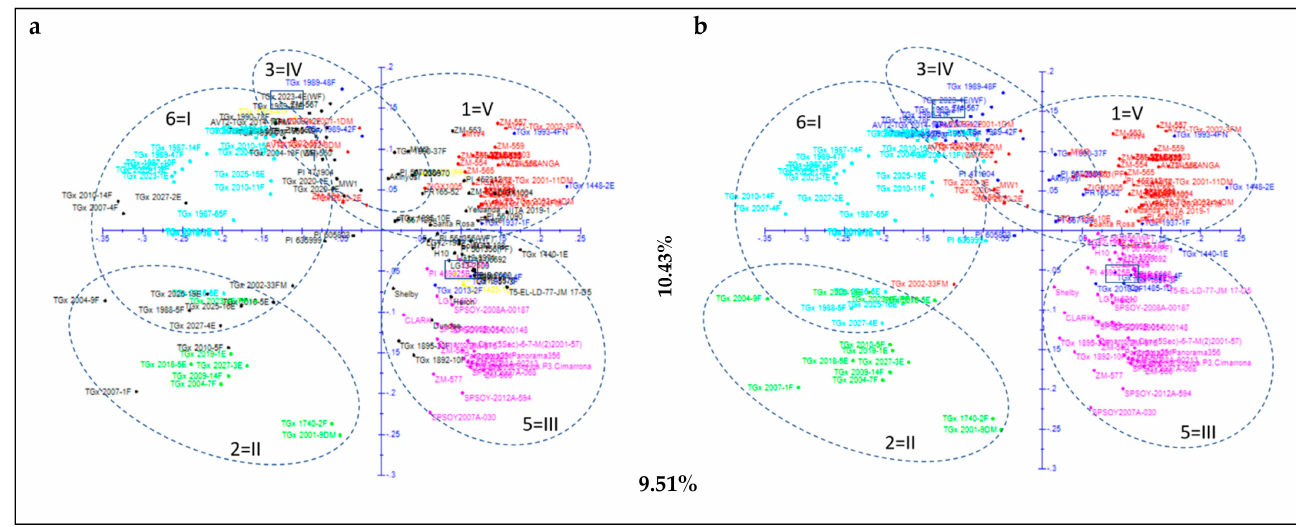
Figure 5. Principal coordinate analysis (PCoA) of the 155 soybean lines. Color-coded according to membership (based on > 60% identity) to subpopulations identified from structure analysis at K = 6 ( a ) and DAPC analysis K = 5 ( b ). Note: numerical corresponding with Roman letters designate subpopulations identified by STRUCTURE and DAPC, respectively. Lines belonging to subpopulation 4 (STRUCTURE) are denoted by